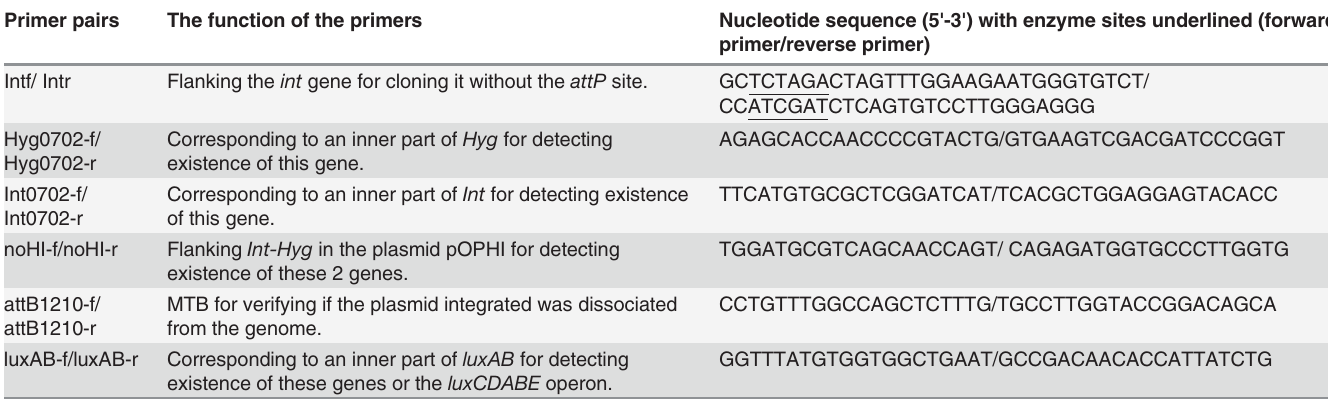
Table 3. DNA primers used in this study. Primer